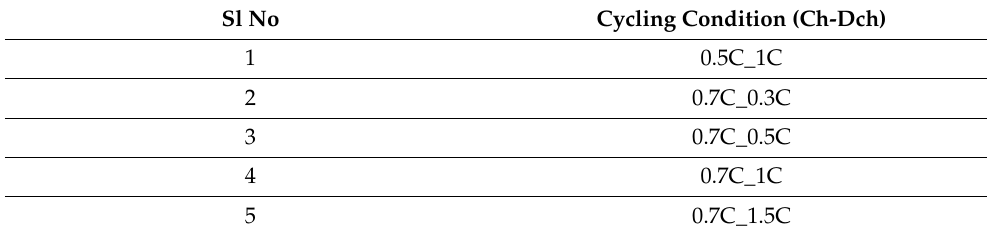
Table 4. Test matrices of this